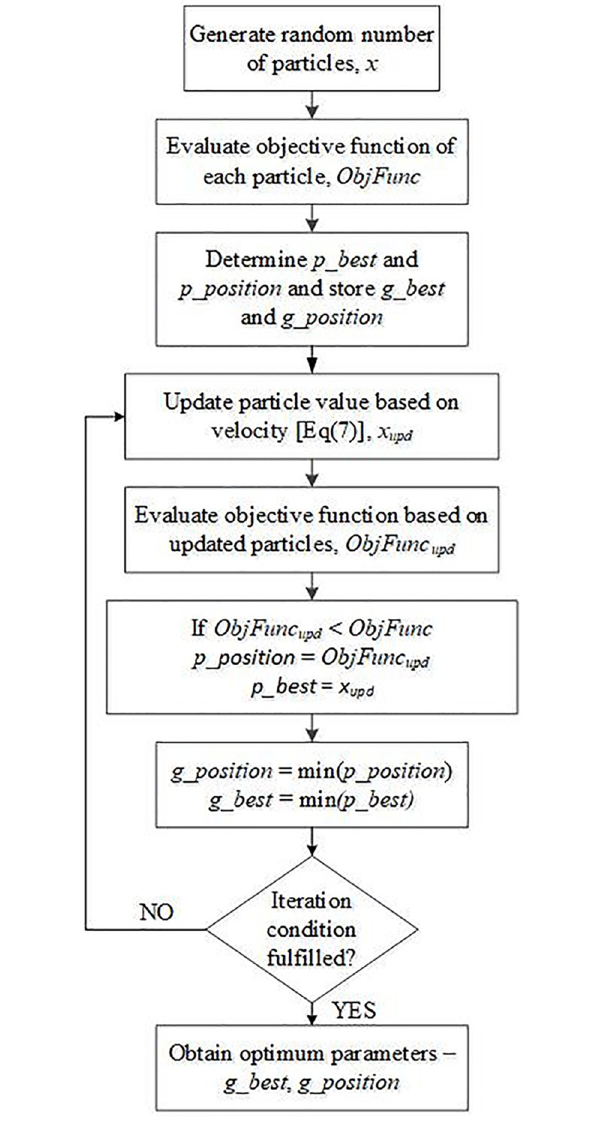
Fig 5. Flowchart of ANN optimization